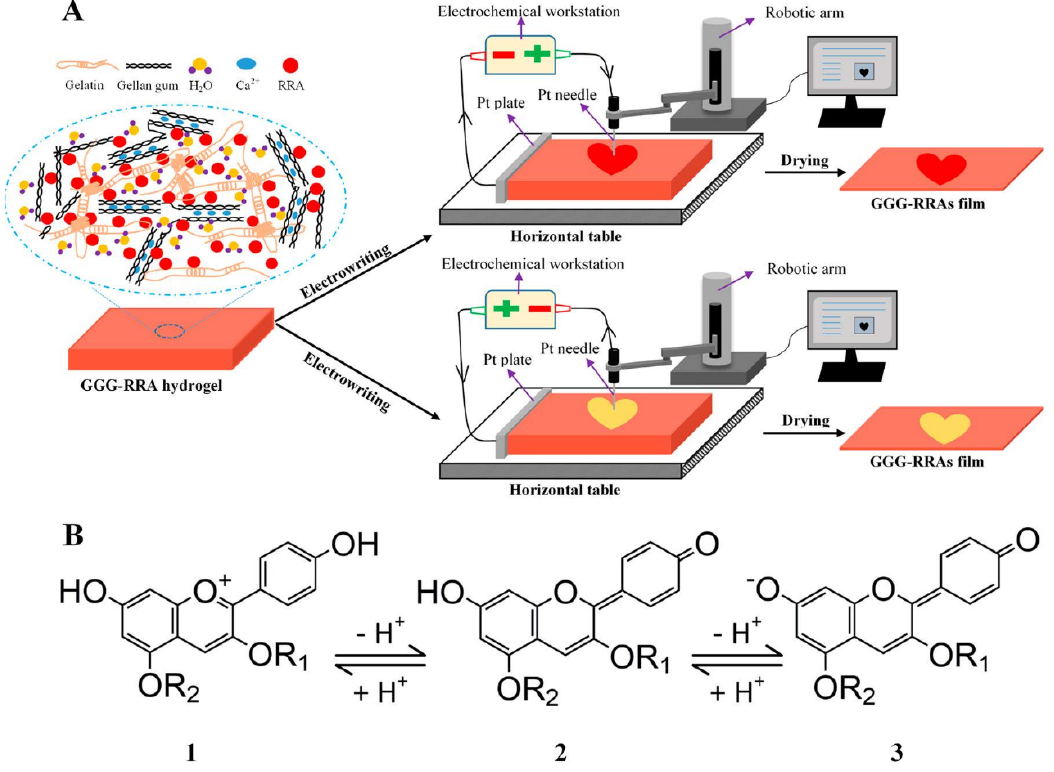
Figure 4. ( A ) Principle of electrochemical writing on pH-sensitive films. ( B ) The structure transfor- mation of red radish anthocyanins in acidic and basic conditions. Source: reprinted with permission from Zhai et al. [150], 2018, ACS.